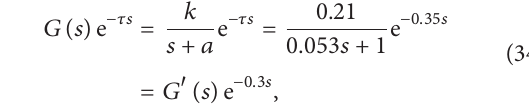
Figure 6. For multiple model adaptive control, four adaptive Smith prediction models are established, corresponding feed- forward and feedback adaptive initial parameters in (12) are 𝐹 in Figure